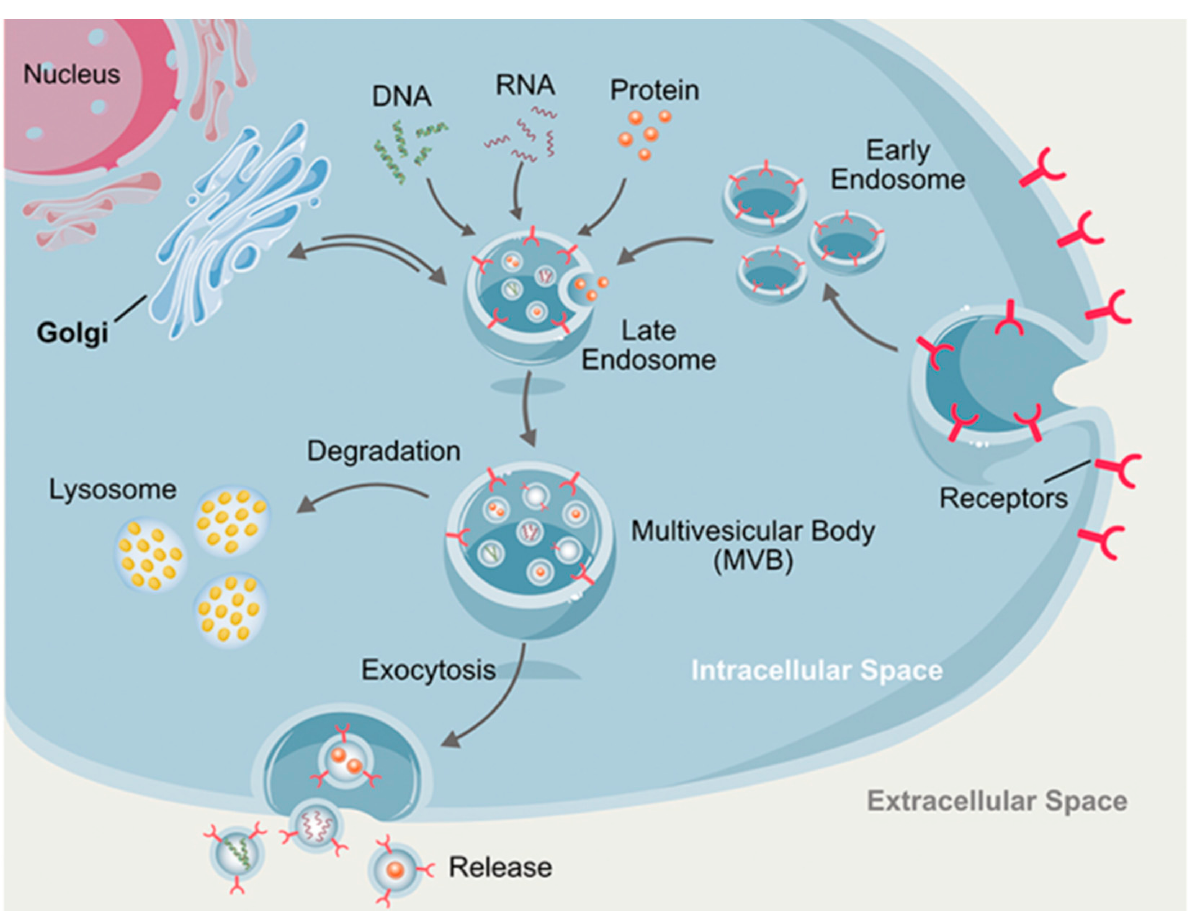
Figure 3. Biogenesis and cargoes of exosomes. Exosome development begins with endocytosis to form early endosomes, later forming late endosomes by inward budding, and finally generating multivesicular bodies (MVBs). MVBs could then either undergo degradation (generating lysosomes) or merge with the cell membrane and, by exocytosis, release intraluminal endosomal vesicles that become exosomes into the extracellular environment. Reprinted with permission from Reference [51].